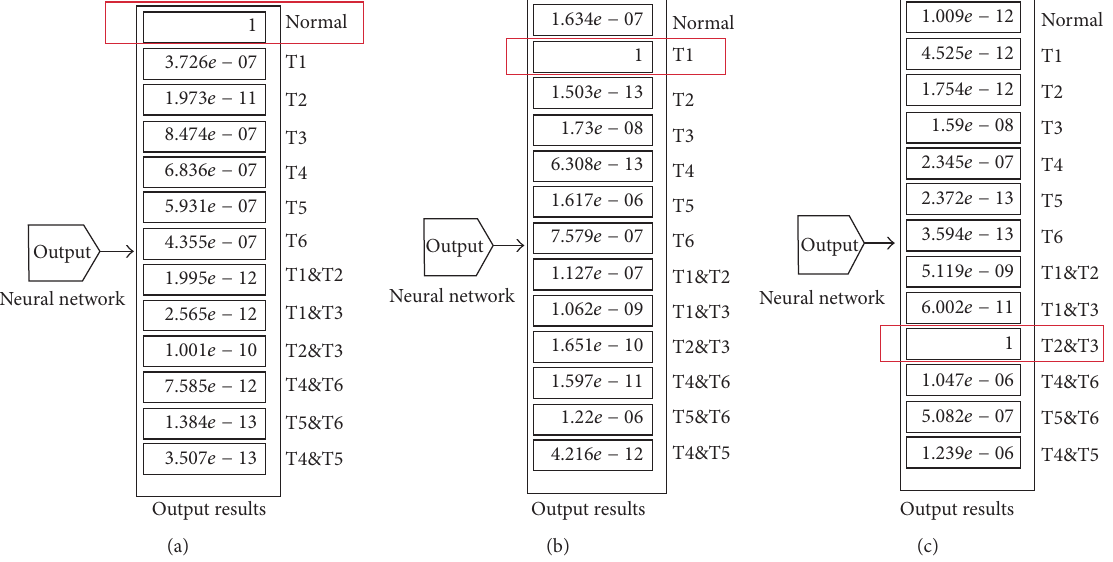
Figure 9: Simulation output results in various modes: (a) normal, (b) single fault, and (c) double fault.